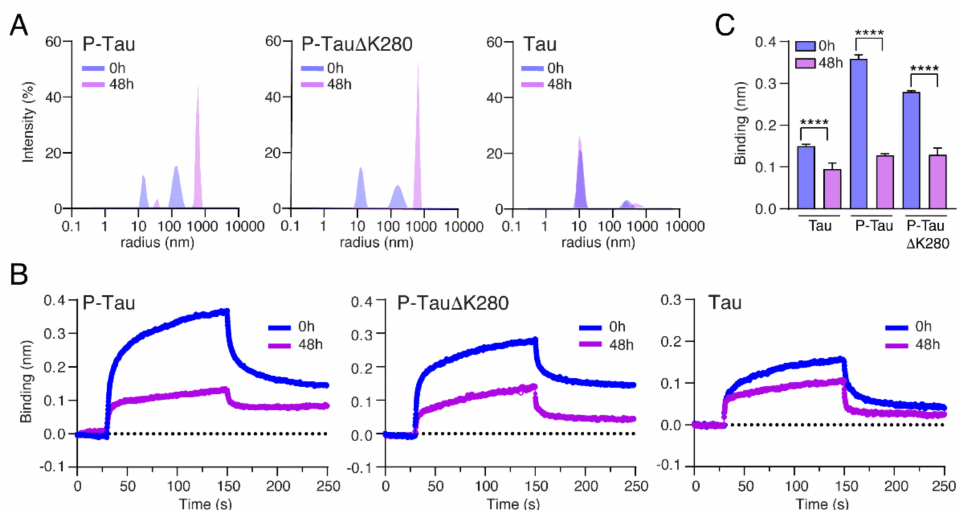
Figure 4. Oligomerization reduces the binding of Tau to Nup98-FG. ( A ) DLS size distribution profiles for Tau, P-Tau, and P-Tau ∆ K280 at 0 h (blue) and 48 h (purple) of the oligomerization process (spontaneous oligomerization at room temperature). Both P-Tau and pro-aggregant P-Tau ∆ K280, but not Tau, show a shift from Tau monomers (radius ~15 nm) at 0 h towards oligomers (radius ~600 nm) at 48 h. ( B ) BLI measurements show a pronounced reduction in binding for oligomerized 48 h-old P-Tau and P-Tau ∆ K280. Tau showed less reduction in binding at 48 h. ( C ) Quantification of the binding (nm) of monomeric (0 h) and oligomeric (48 h) Tau versions at the end of the association phase ( t = 150 s). Data are the mean + SD of the last five values of the association phase. Two-tailed Student’s t -test, unpaired, **** p <